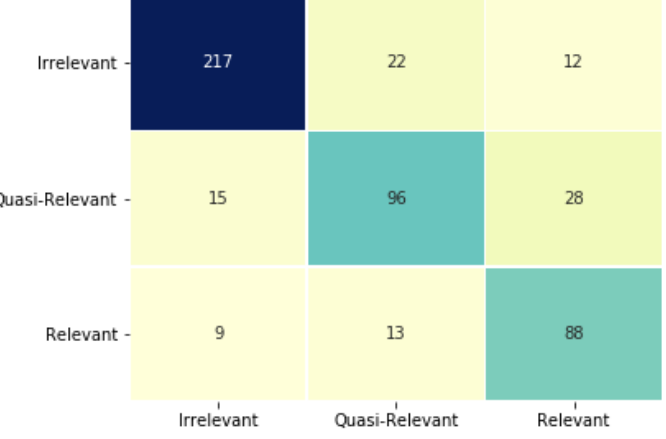
Figure 3. Confusion matrix for classifier predictions on earnings call transcripts (F1 =